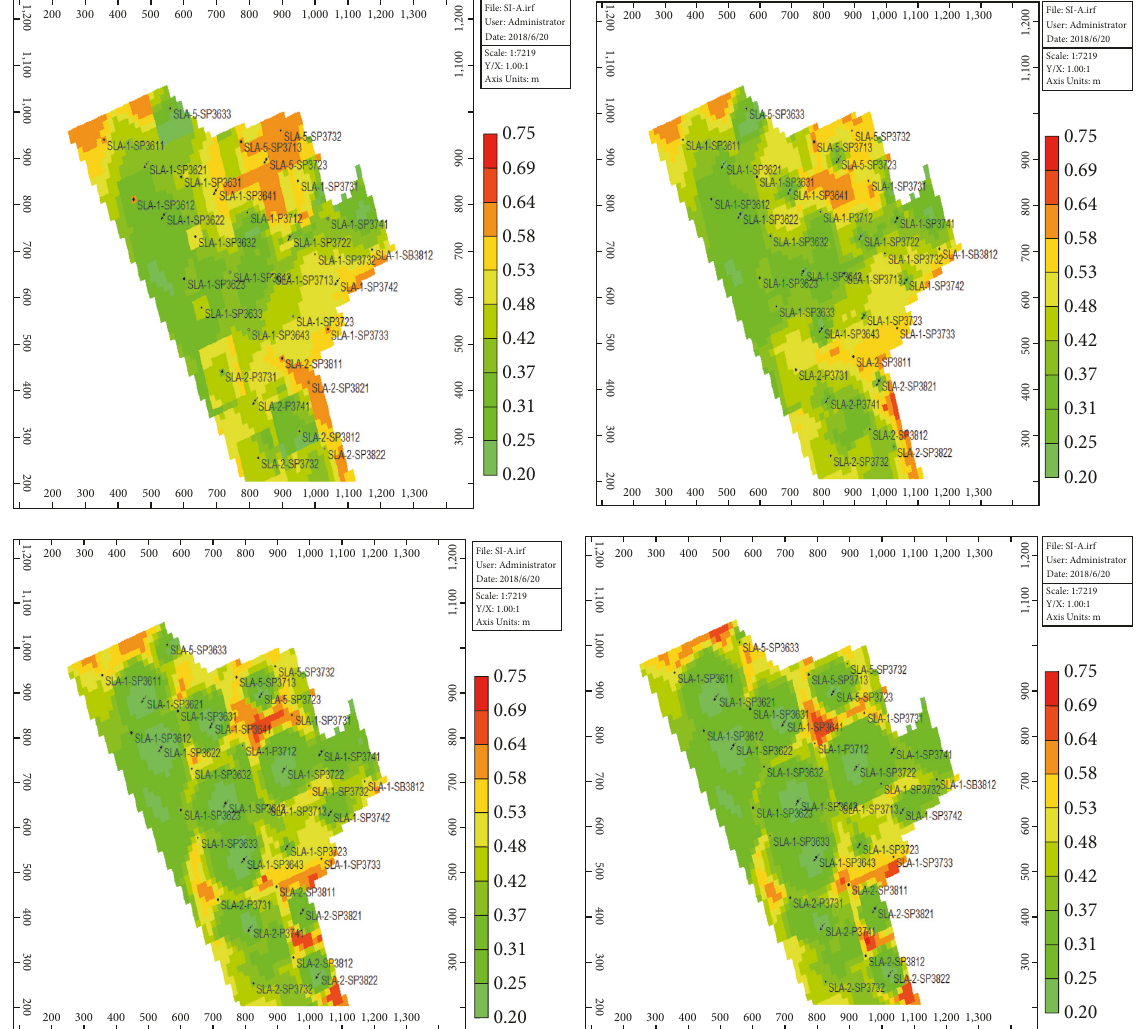
Figure 15: Distribution map of residual oil in SL- Ι